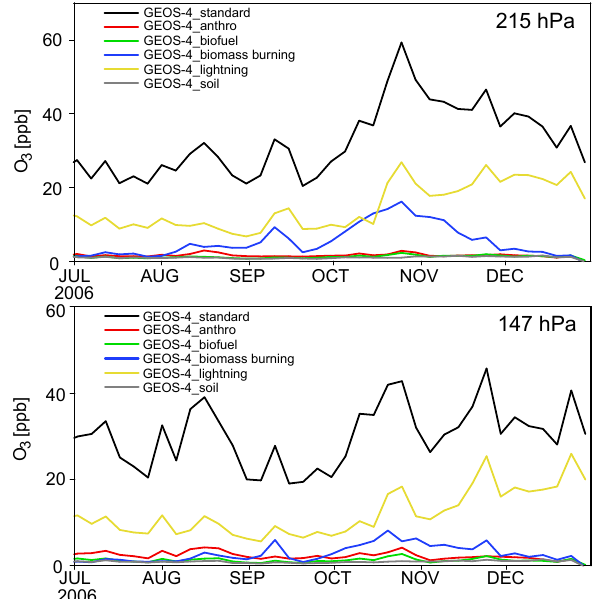
Fig. 14. Simulated upper tropospheric O 3 concentrations with and without lightning NO x emissions from July to December of 2005 and 2006. Values are from GEOS-Chem simulations driven by GEOS-4 meteorological data and are averaged (5-day) over the WCI domain.